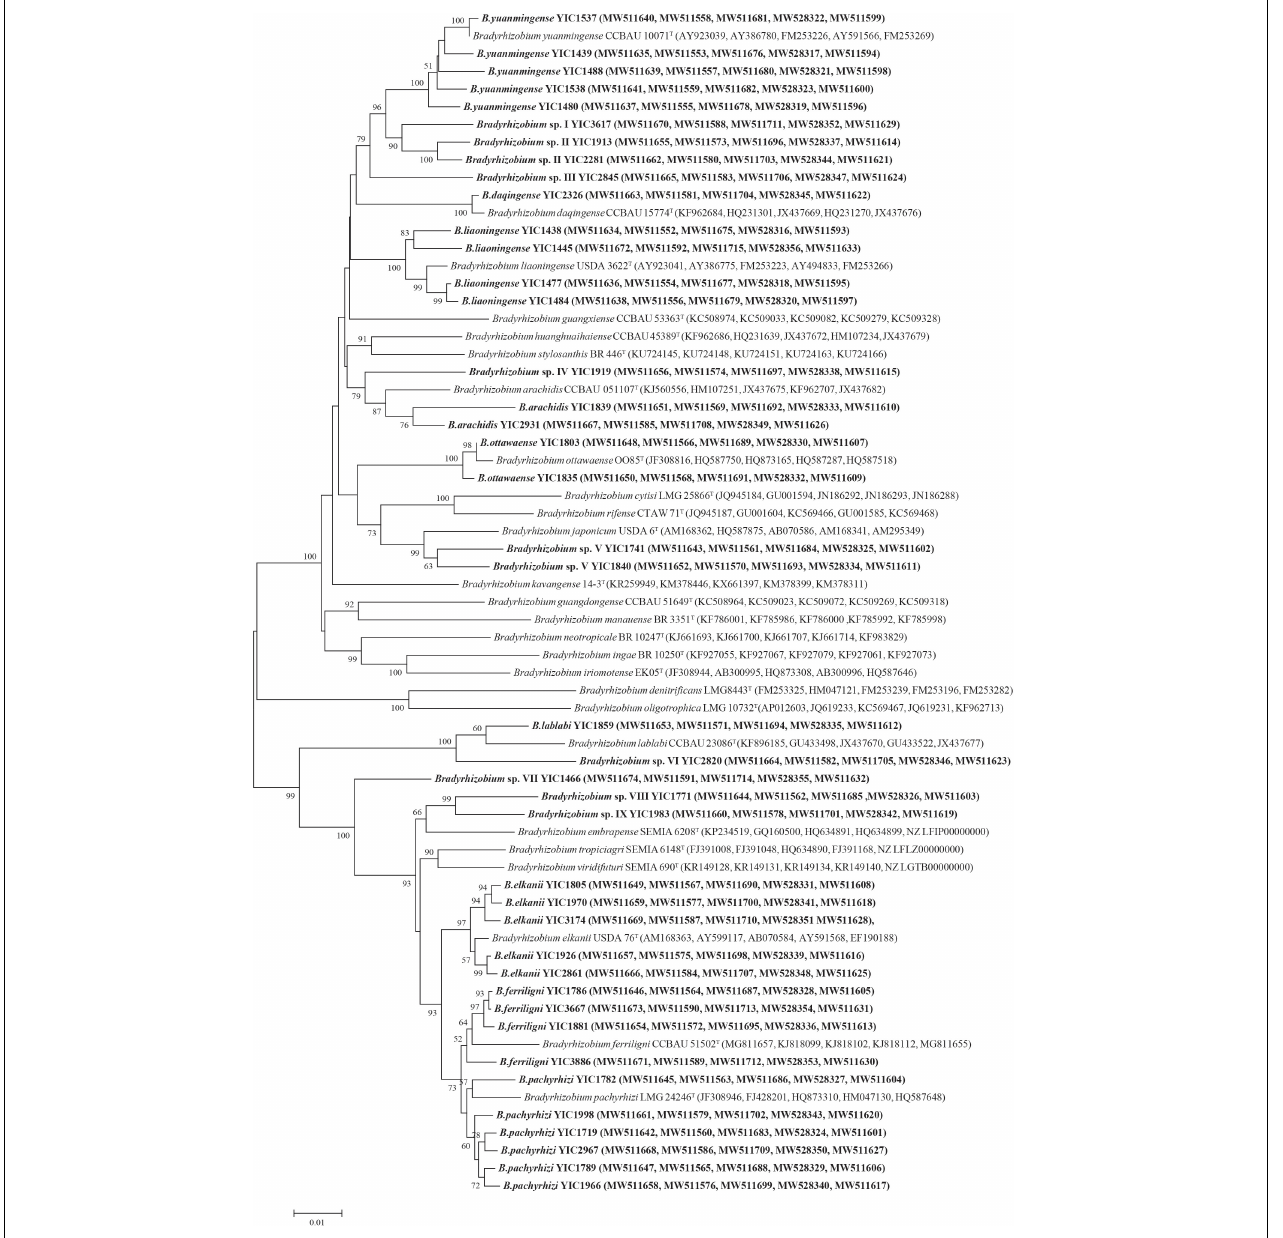
FIGURE 2 | Multilocus sequence analysis (MLSA) phylogenetic tree based on concatenated sequence of dnaK (451 bp), glnII (558 bp), gyrB (605 bp), recA (455 bp), and rpoB (761 bp). Taxa and GenBank accession numbers in boldface were isolated and determined in this study. The tree was constructed by the neighbor-joining method using MEGA 7.0. Bootstrap values larger than 50% are shown at the nodes. The scale bar represents 1% substitution of the nucleotide.